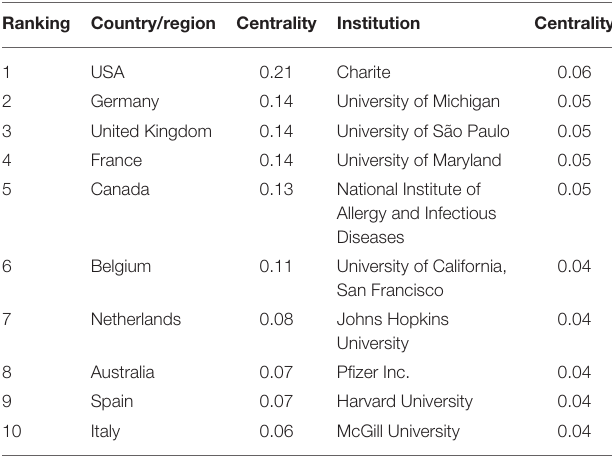
TABLE 2 | Top 10 countries/region and institutions in terms of centrality for herpes zoster. Ranking Country/region Centrality Institution